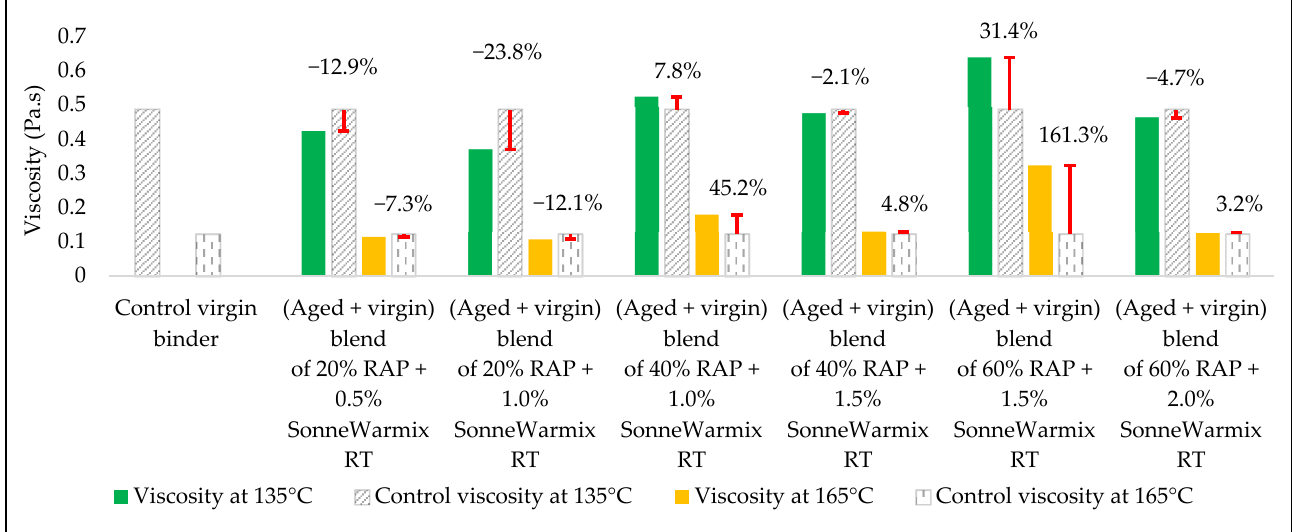
Figure 19. The change in viscosity level from adding DSO as a rejuvenator to the combined blend of binders in comparison to the control viscosity of the virgin binder.